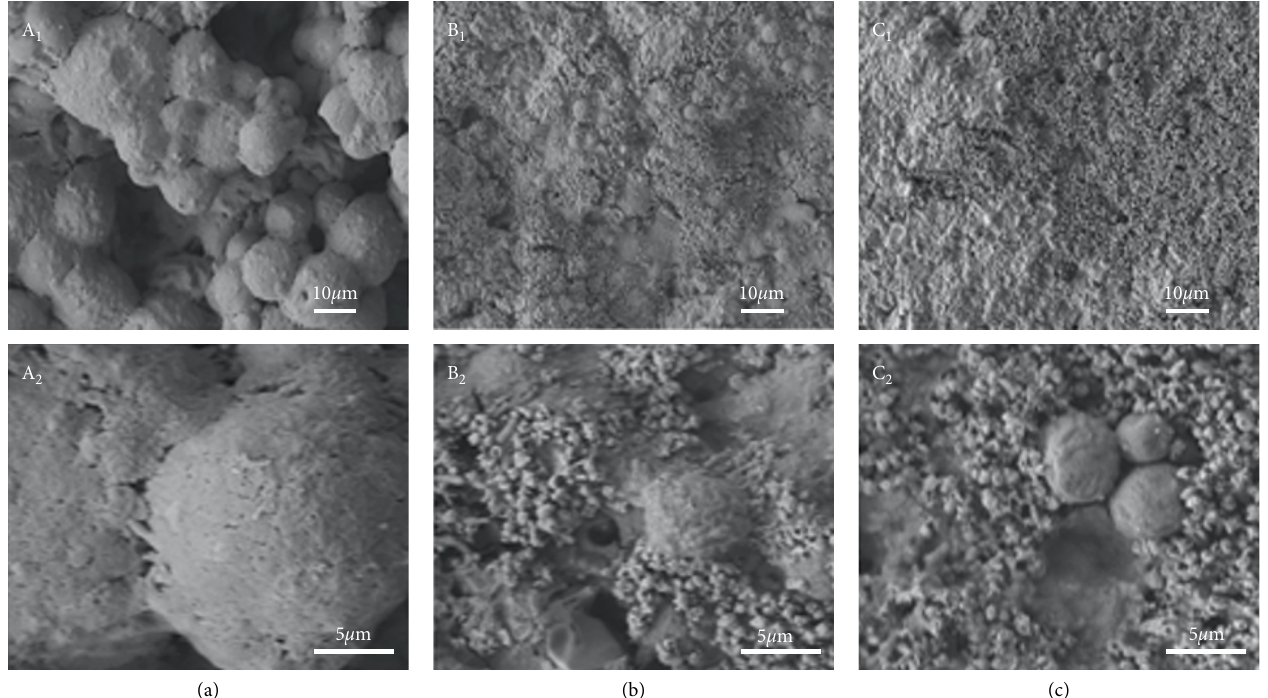
Figure 8: SEM images showing the GMs and TCP@GMs after release for 28 days. (a) GMs; (b) TCP@GMs3367, and (c) TCP@GMs5050.